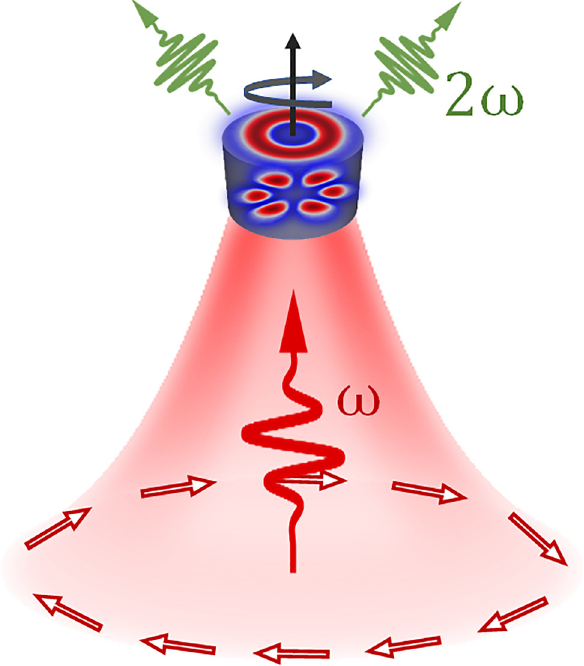
Figure 1: Schematic of the geometry. Azimuthally polarized cylindrical vector beam of frequency ω excites an axially symmetric supercavity mode in the nanodisk. As a result of nonlinear interaction, the second-harmonic light of 2 ω is